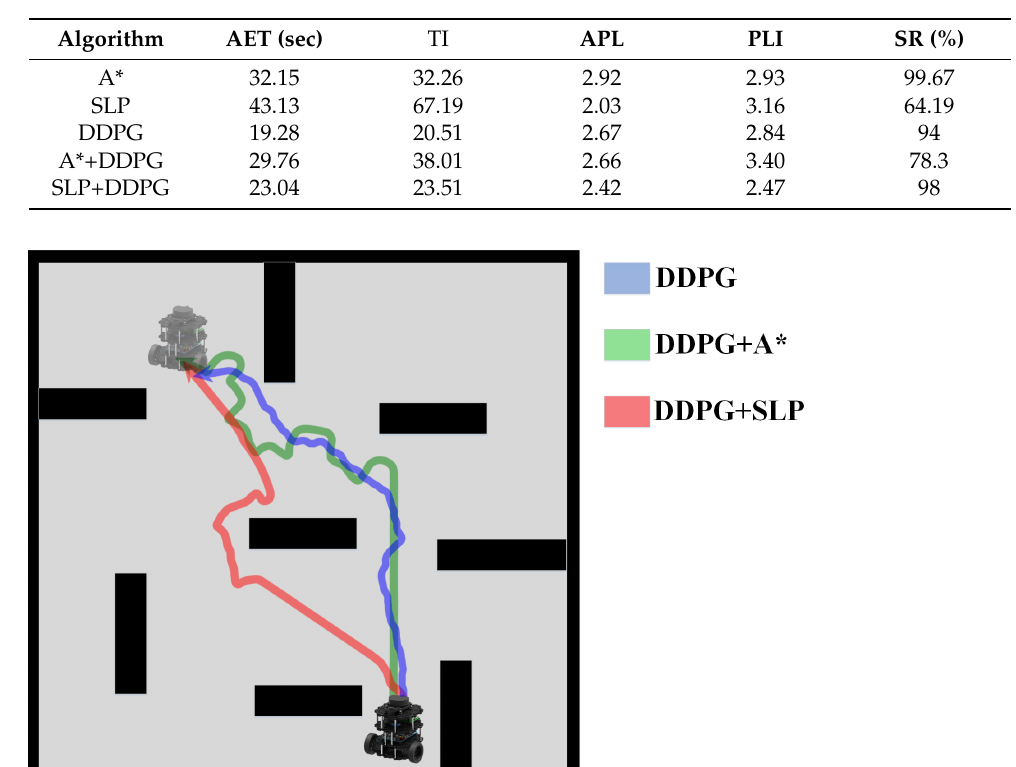
Figure 7. Trajectory Comparison in Static Environment. Table 1. Test Case 1 (Static Environment).